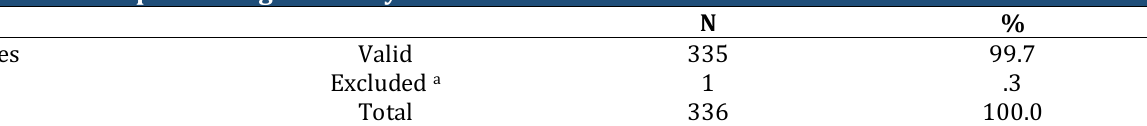
Table 4: Case processing summary